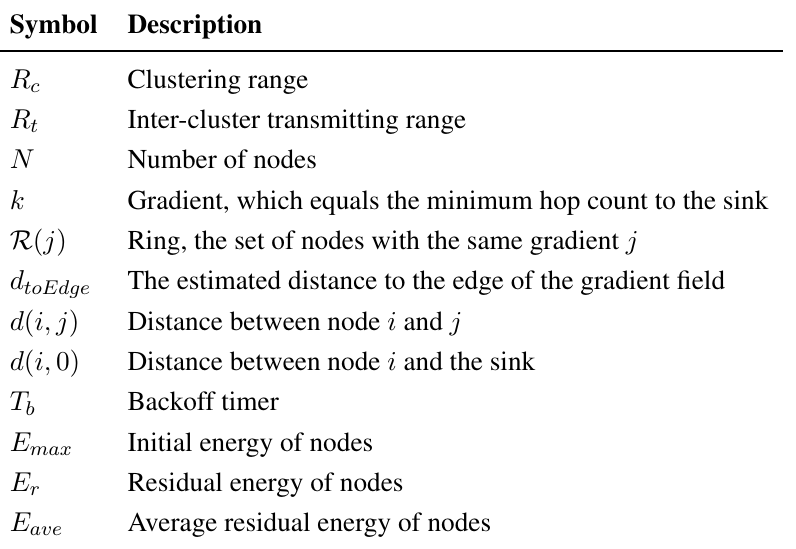
Table 1. List of